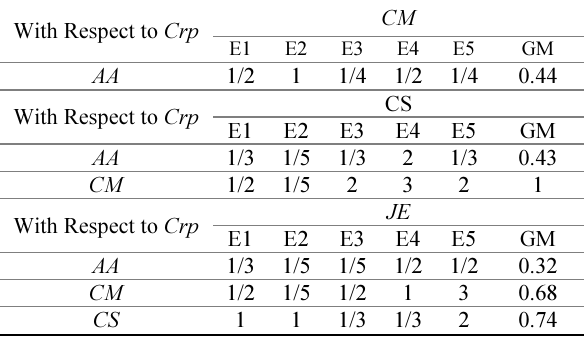
Table 5. Transformation of Pair-wiser to group pairwise comparison